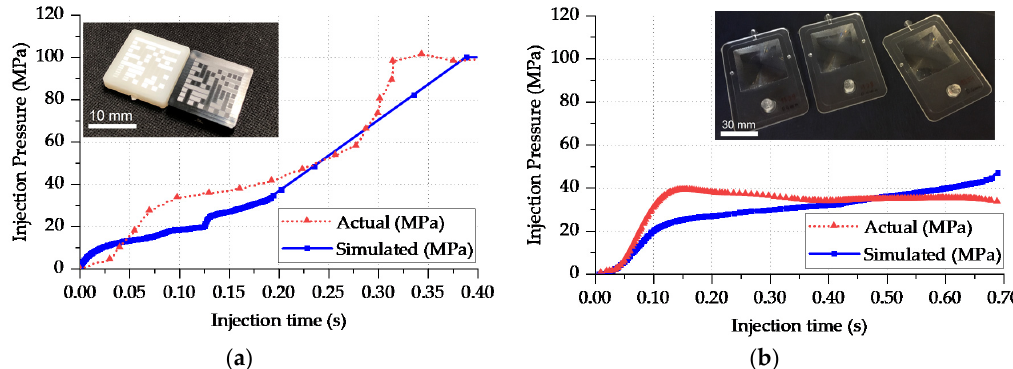
Figure 16. Injection pressure at the injection location comparison from the simulation and actual value for Cases 3 ( a ) and 4 ( b ).